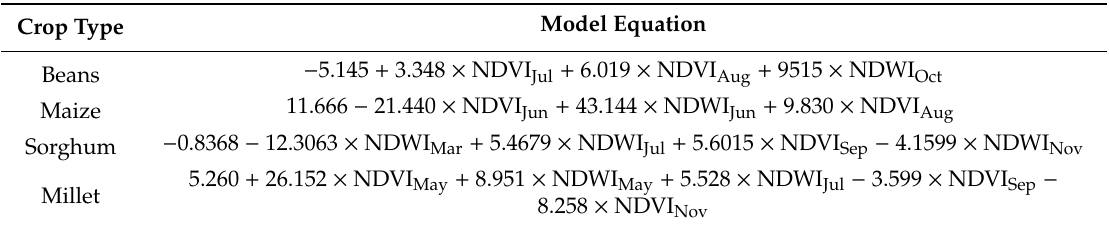
Table 2. MLR model equations per crop type.